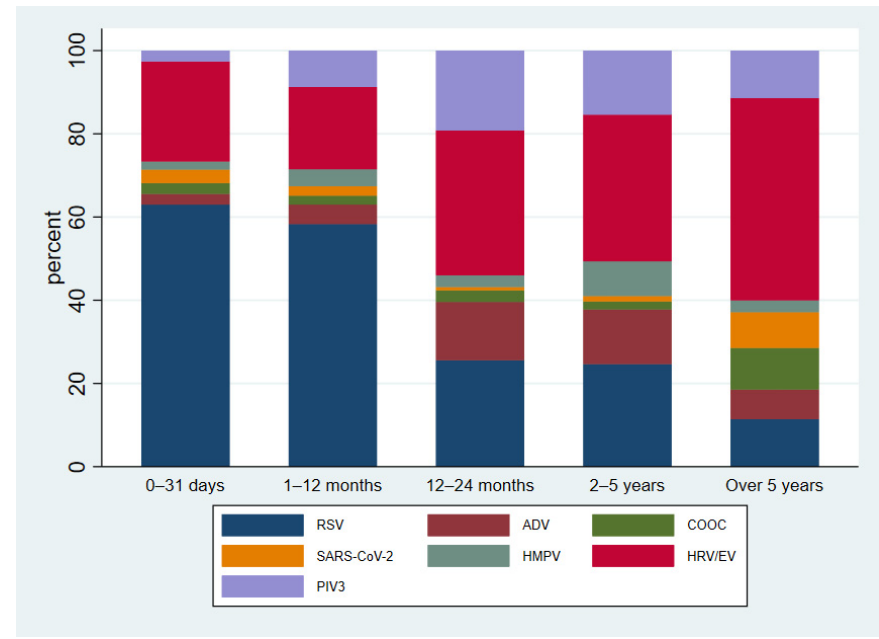
Figure 1. Distribution of detected pathogens according to patients’ age.